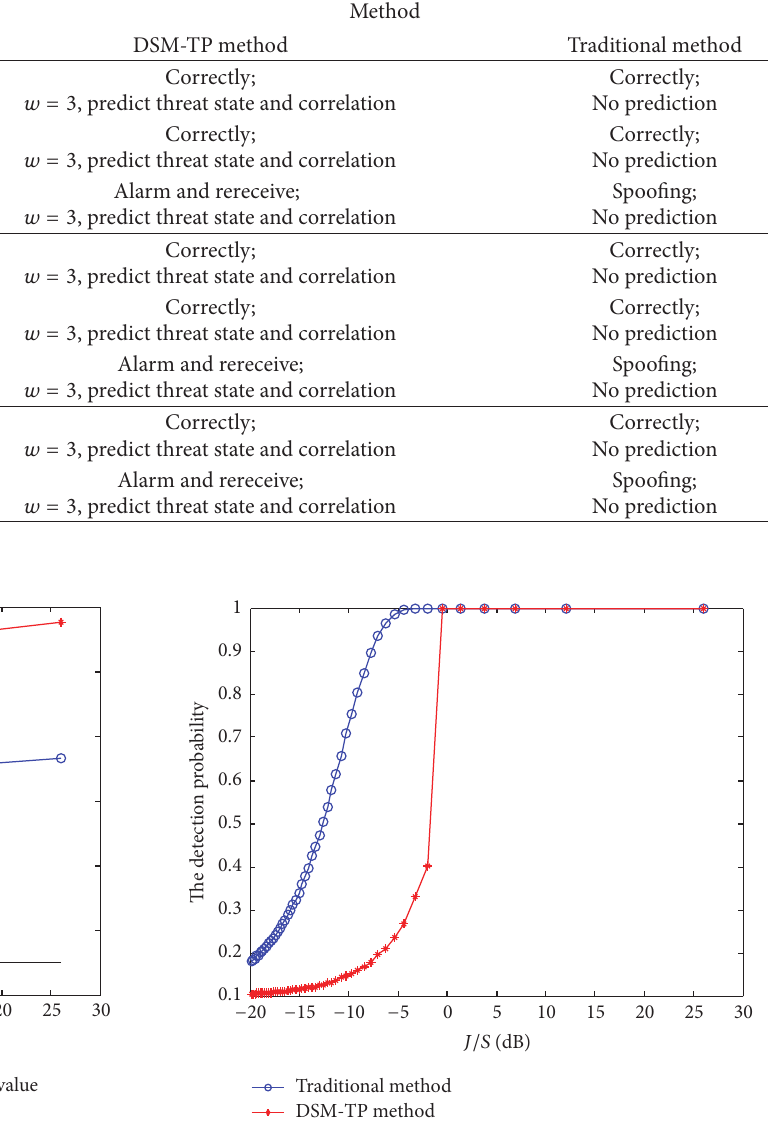
Figure 16: Proportion peak for changing S/J . Figure 17: Detection probability for changing S/J